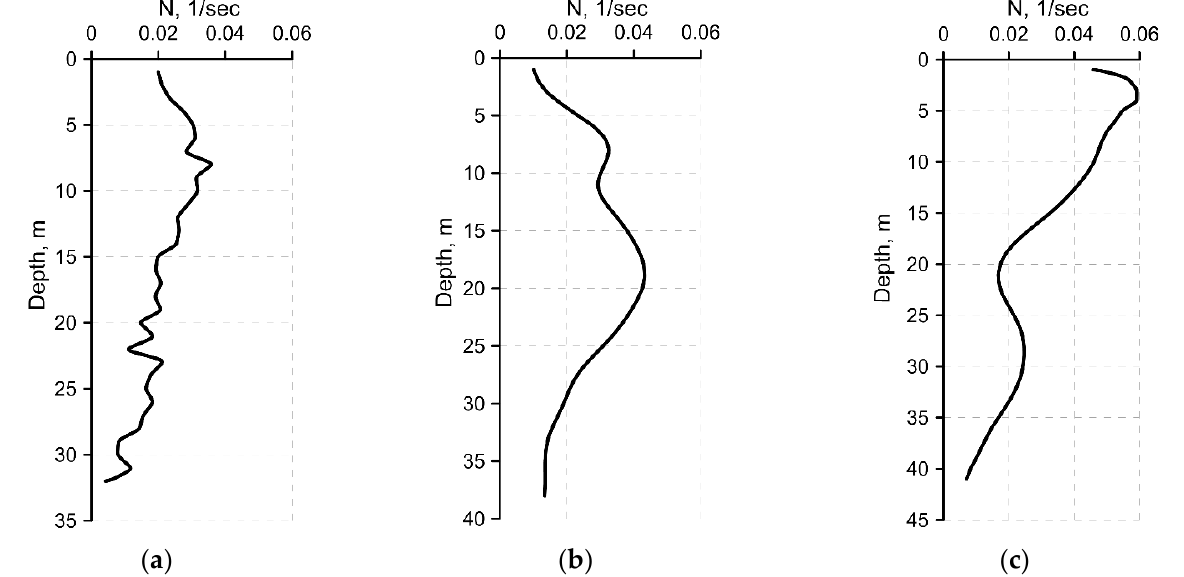
Figure 6. Vertical profiles of buoyancy frequency at polygons: ( a ) one in summer, 2010; ( b ) 4 in summer, 2012; and ( c ) 7 in summer, 2012.